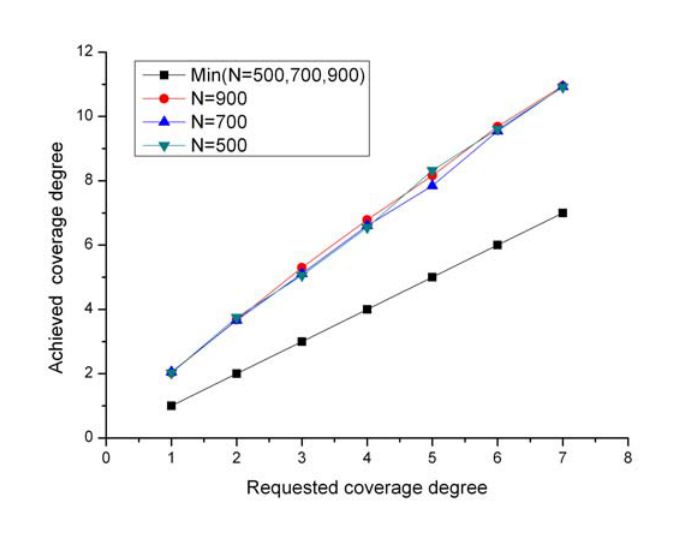
Figure 9. Achieved coverage degree by